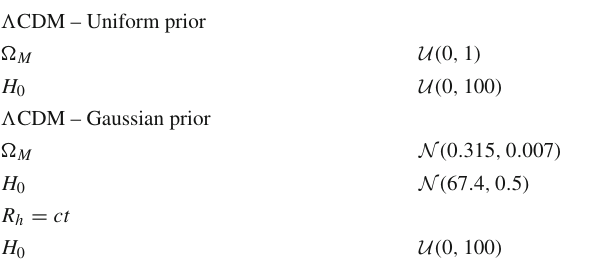
Table 2 The priors used for the analysis. U ( x , y ) denotes a top-hat or a uniform prior between x and y . N ( x , y ) denotes a Gaussian prior with a mean of x and scale parameter of y . The Gaussian priors for (cid:2) CDM are centered around the best fit values of the 2018 results of Planck collaboration [8], with the scale parameter equal to 1 σ error of these results. The priors on H 0 are given in units of